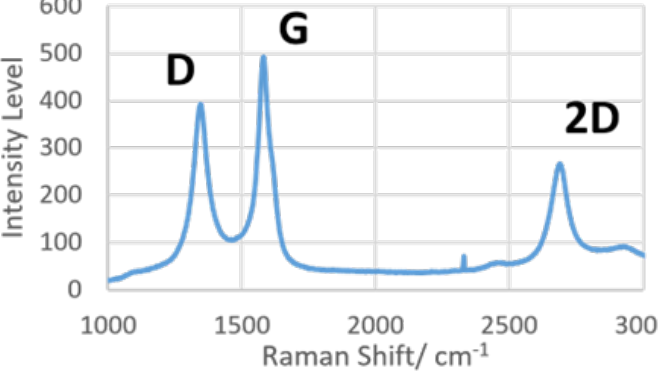
Figure 5. Raman spectra of laser-induced graphene produced with 200 mW laser power.